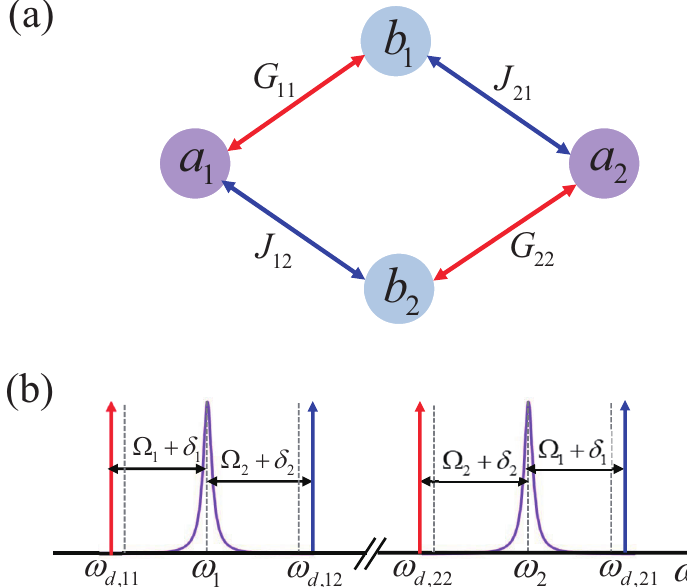
Figure 1. ( a ) Schematic of the optomechanical system. Two cavity modes a 1 and a 2 are, respectively, coupled to two mechanical modes b 1 and b 2 with the effective optomechanical coupling strengths G 11 , J 12 , J 21 , and G 22 . ( b ) Frequency domain schematic of the four-tone driving scheme. Cavity mode a 1 with resonance frequency ω 1 is driven by two tones at frequencies ω d ,11 = ω 1 − ( Ω 1 + δ 1 ) and ω d ,12 = ω 1 + ( Ω 2 + δ 2 ) . Cavity mode a 2 with resonance frequency ω 2 is driven by two tones at frequencies ω d ,21 = ω 2 + ( Ω 1 + δ 1 ) and ω d ,22 = ω 2 − ( Ω 2 + δ 2 )